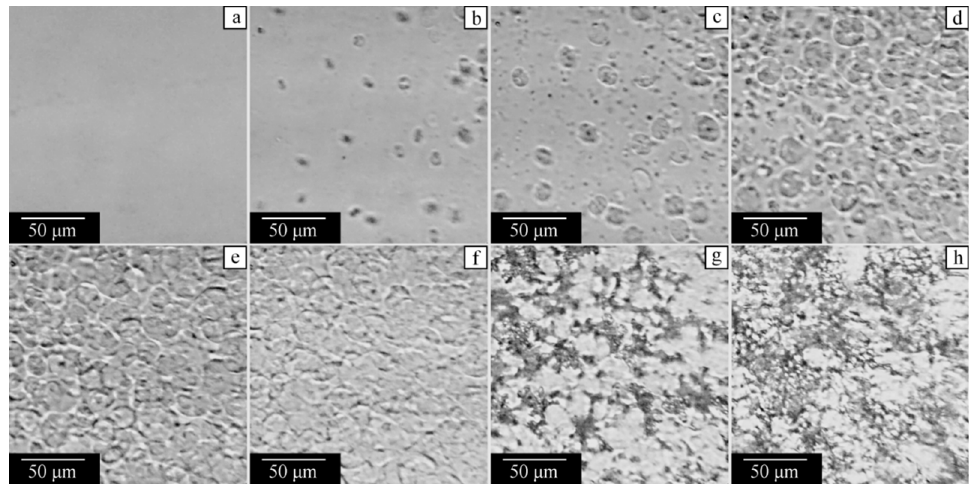
Figure 11. Optical micrographs of the PVDF–camphor mixture with 75 wt% of PVDF taken on cool- ing from the homogeneous state at ( a ) 180, ( b ) 124, ( c ) 122, ( d ) 119, ( e ) 117, ( f ) 114, ( g ) 106, and ( h ) 75 °C.